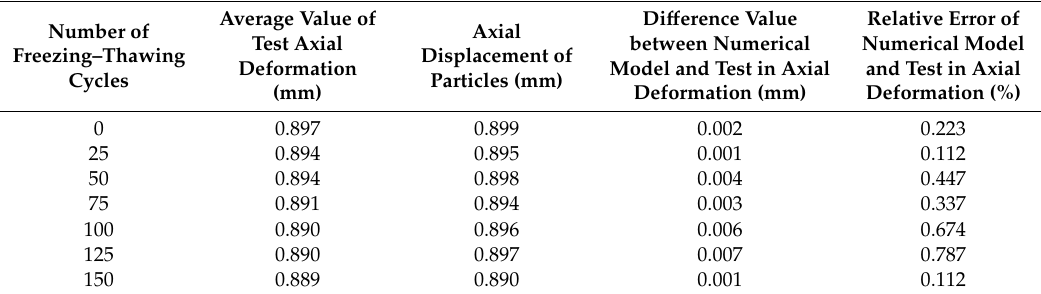
Table 5. Comparison of uniaxial compression deformation and particle axial displacement of concrete under different numbers of freezing–thawing cycles.